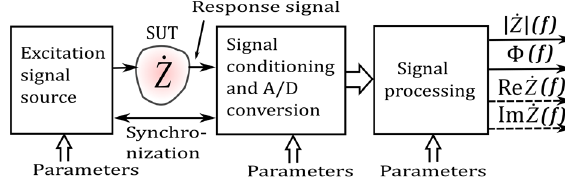
Fig.1: Simplified structure of the EBI spectroscopy